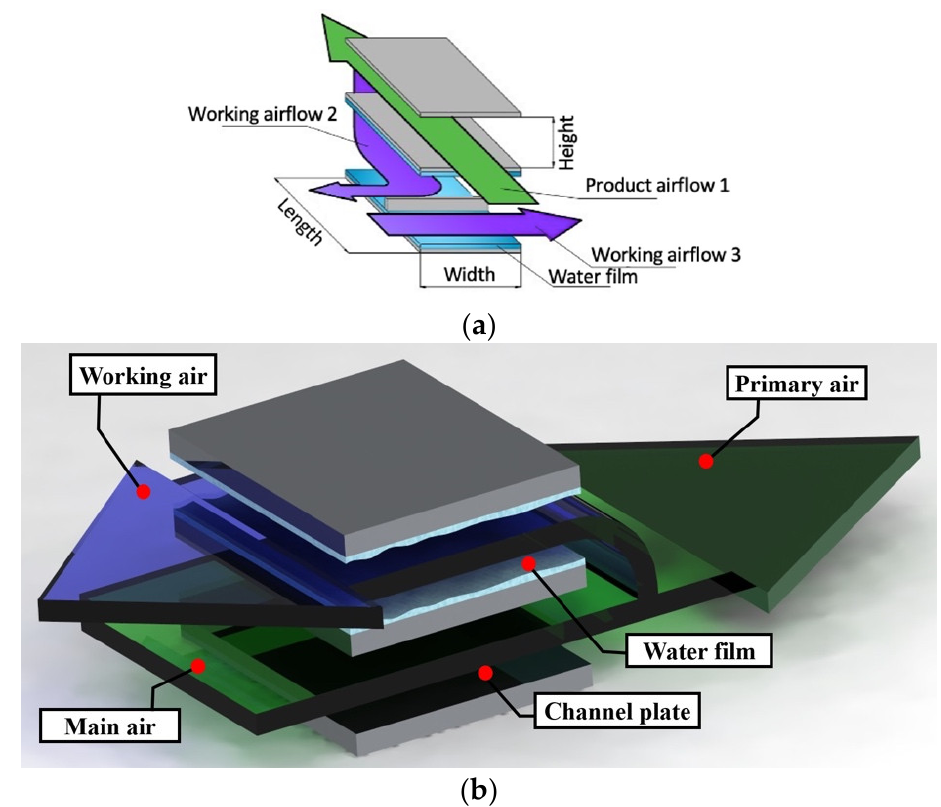
Figure 1. Evaporative coolers schemes. ( a ) Multi-stage dew-point evaporative cooler. ( b ) Regenerative cooler [17].